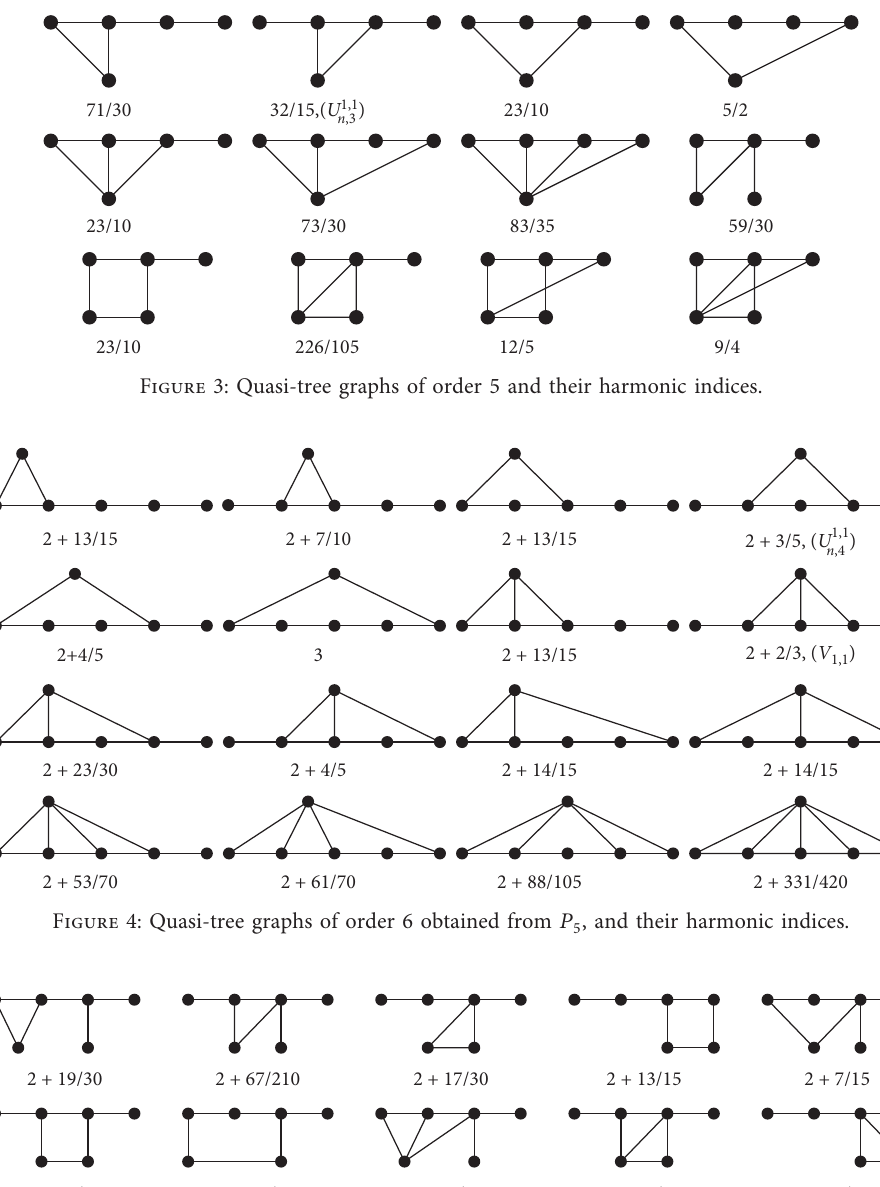
, and their harmonic indices. 5